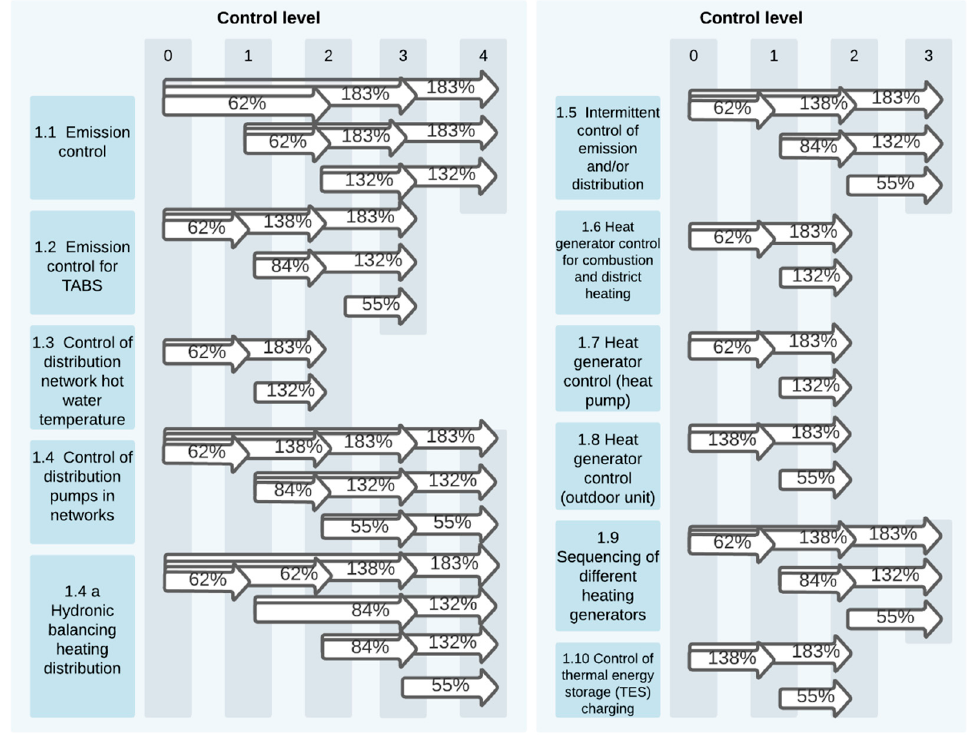
Figure 5. Allowed investment for upgrades to the control level of separate heating services for residential apartment buildings.